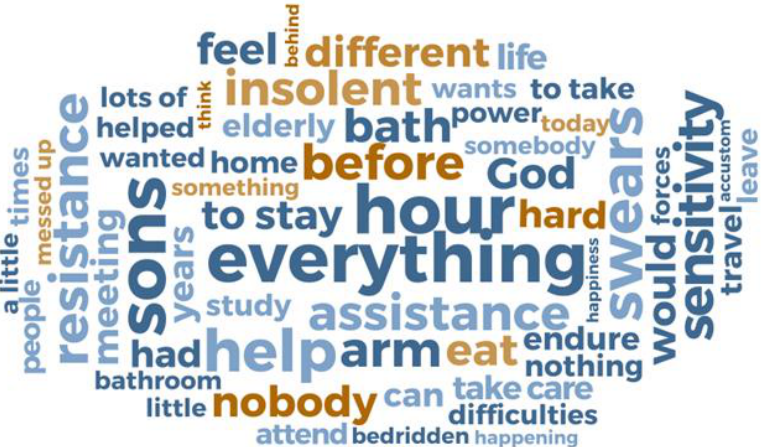
Figure 2. Word cloud. Difficulties in caring pointed out by Brazilian caregivers. Via QSR NVivo ® .